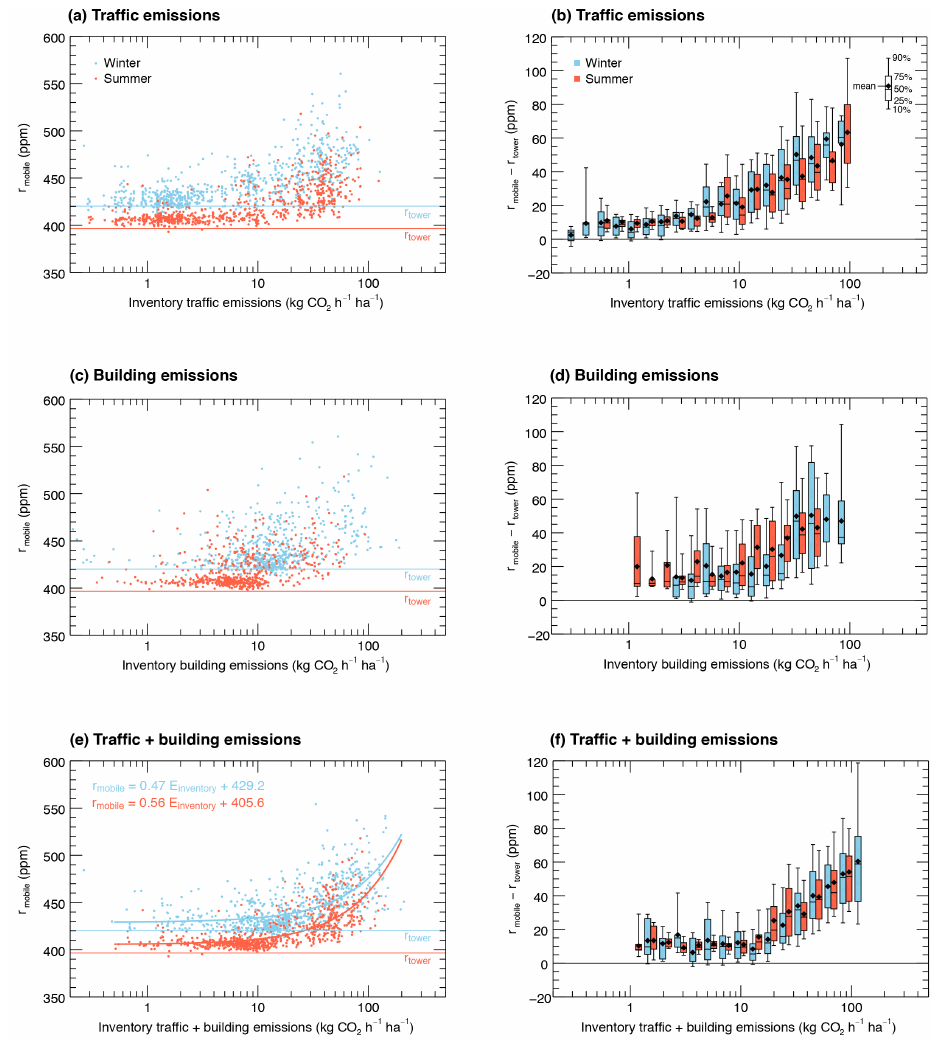
Figure 8. (a, c, e) Comparison of inventory (traffic only, building emissions only, and total emissions) against grid-averaged mixing ratios ( r mobile ), where each dot is a 100 × 100m grid cell. Note that the x axis is logarithmic. The curves in (e) are linear fits. (b, d, f) Comparison of inventory (traffic only, building emissions only, and total emissions) to the difference between grid-averaged mixing ratio r mobile and the mixing ratio measured at the